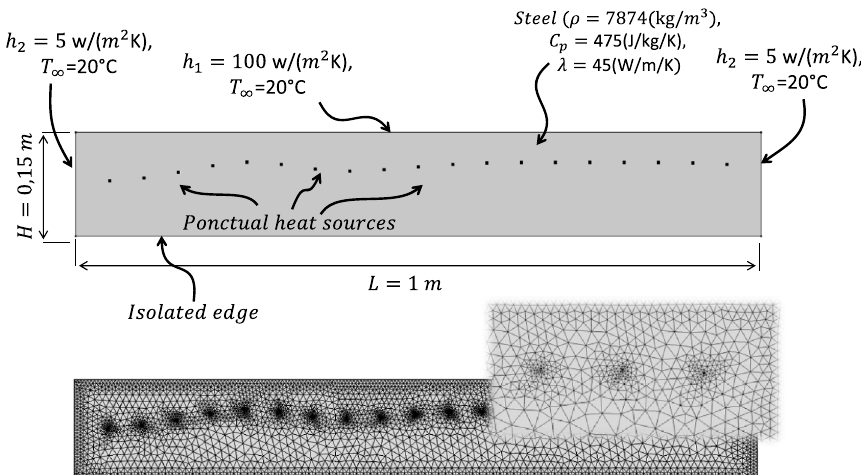
Fig. 6. Geometry, mesh and boundary conditions used for the 2D model of the studied heating